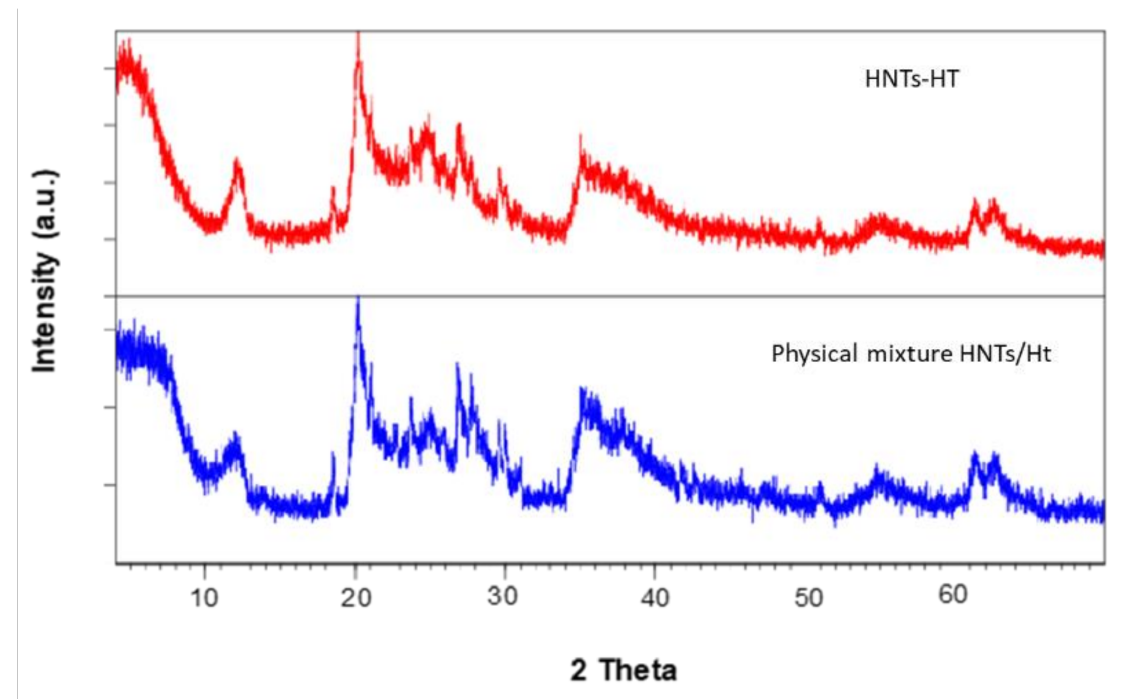
Figure 4. Comparison between the XRD patterns of HNTs/Ht physical mixture and HNTs-Ht nanomaterial.